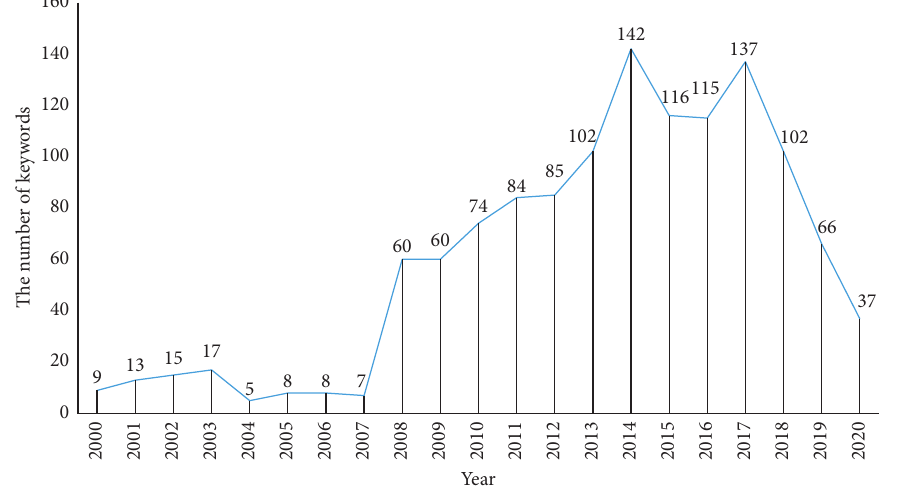
Figure 5: The trend of keyword, sports